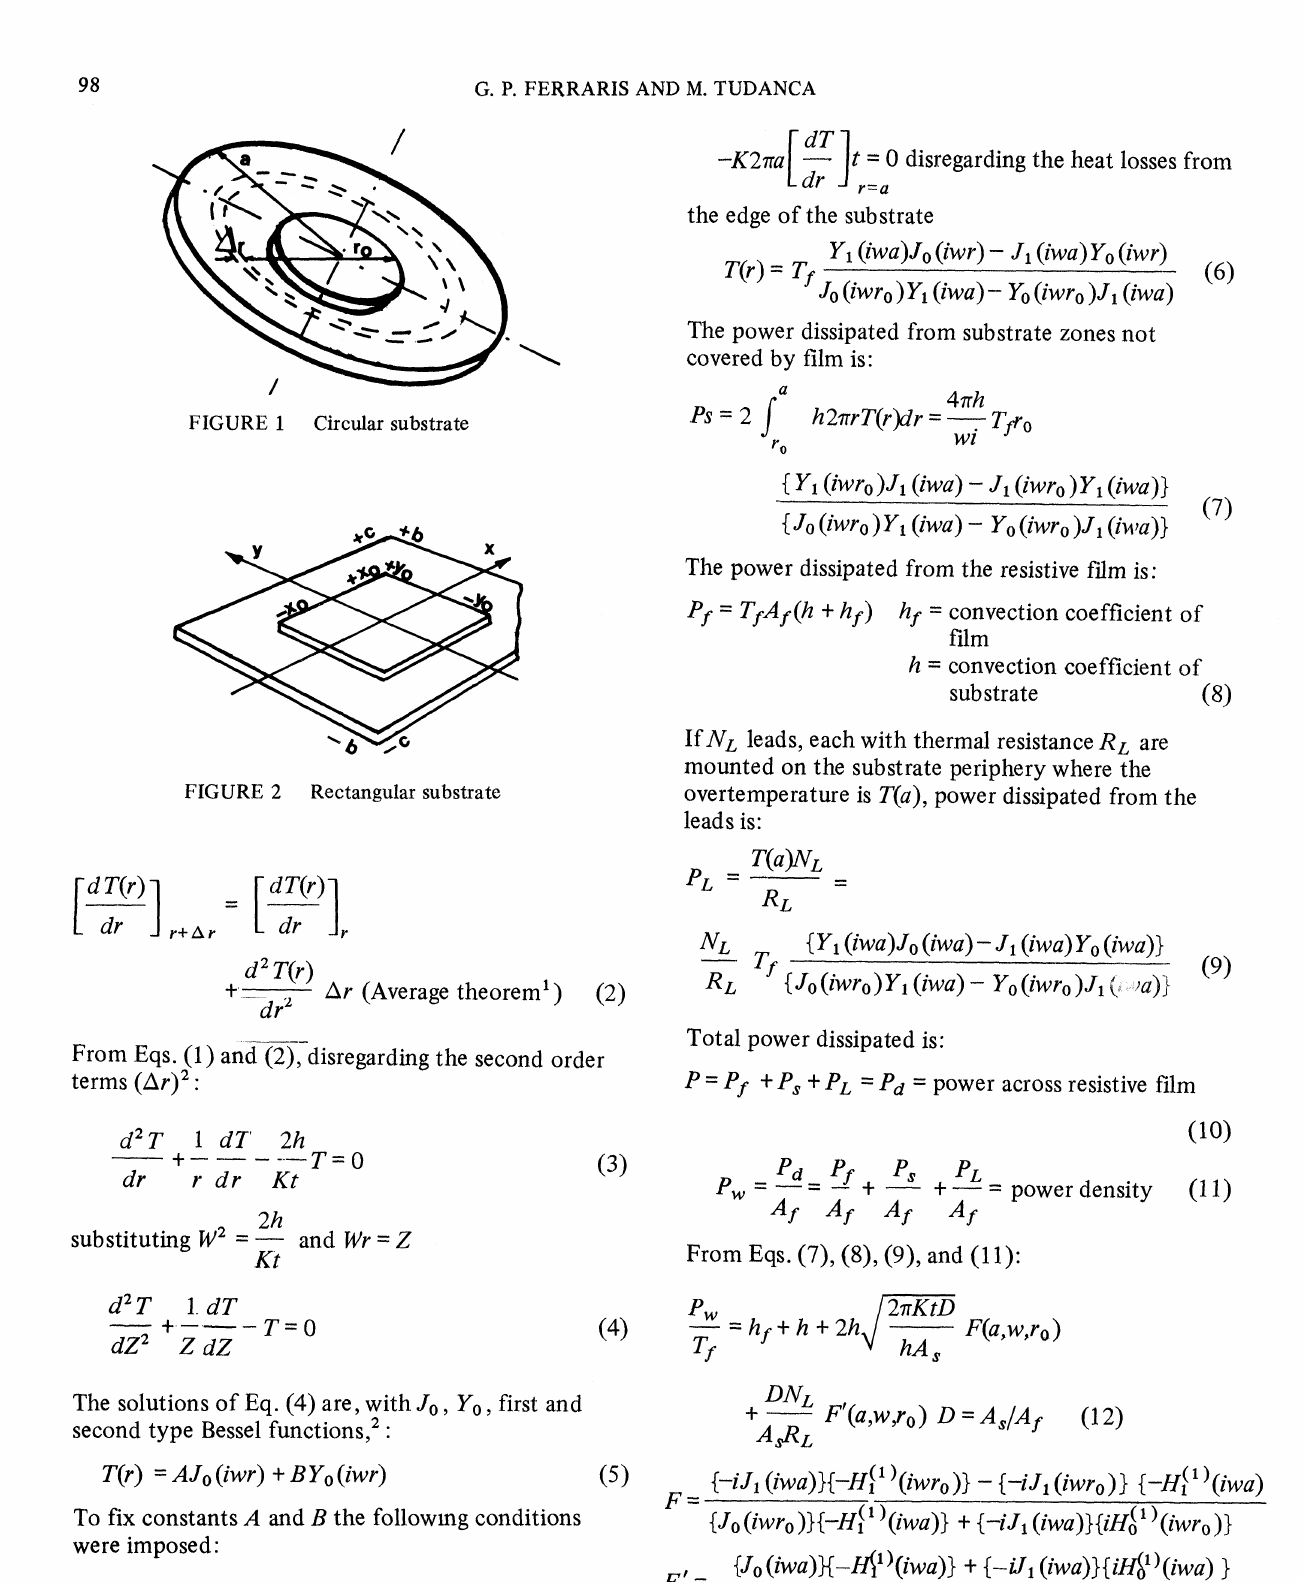
Circular substrate